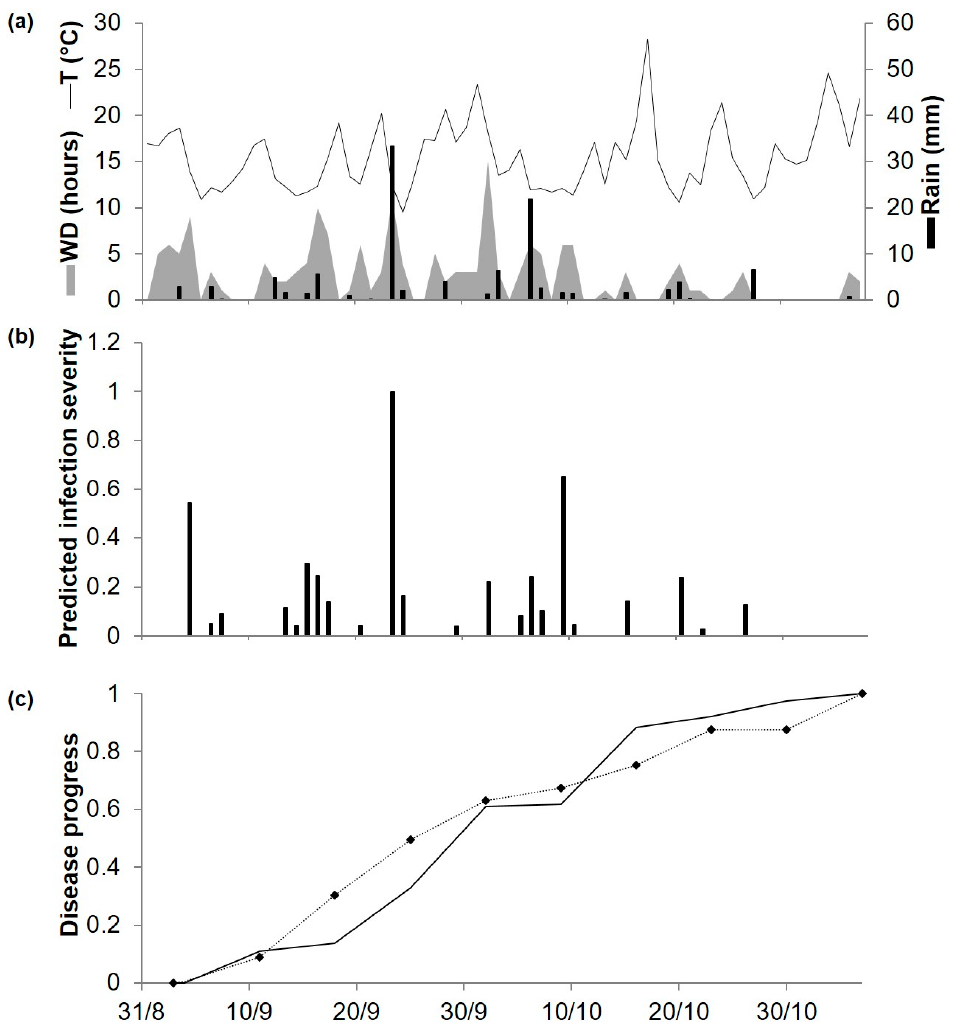
Figure 6. Predicted and observed disease progress (Ascochyta blight) on cv. Kaniva at the University of Adelaide’s Waite Campus, Australia, in 1998. ( a ) Weather variables: air temperature (T, °C, solid line), rainfall (Rain, mm, black bars), leaf wetness duration and (WD, hours, grey area). ( b ) Bars represent the infection severity predicted by the model. ( c ) Solid line represents the accumulated infection severity predicted by the model and rescaled to the final value of the year. Dotted line represents the accumulated value of Ascochyta blight severity rescaled final value of the year (40%).